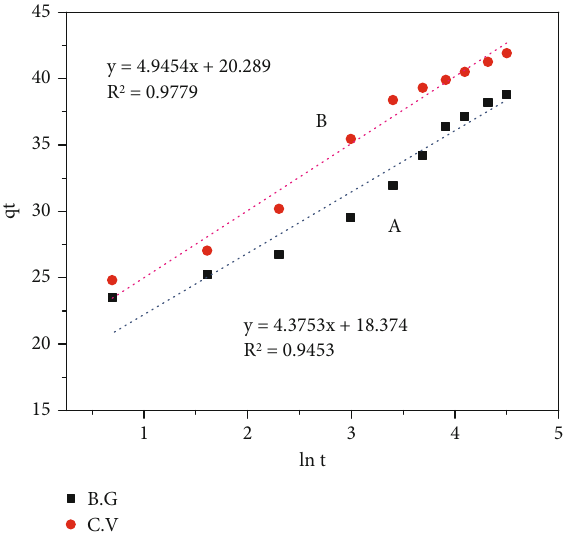
Figure 16: Elovich model graph for B.G. and C.V. dyes ’ uptake on NCs versus time. 2 the surface of binary P3NT/30%AgTiO Experimental conditions are illustrated in the batch extraction